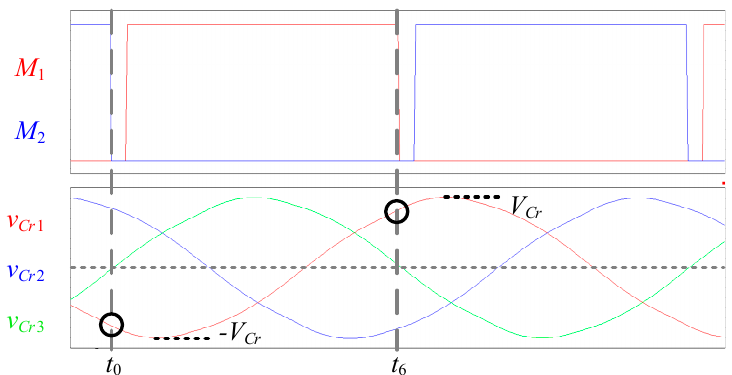
Figure 15. Waveform of symmetrical resonant capacitor voltage.